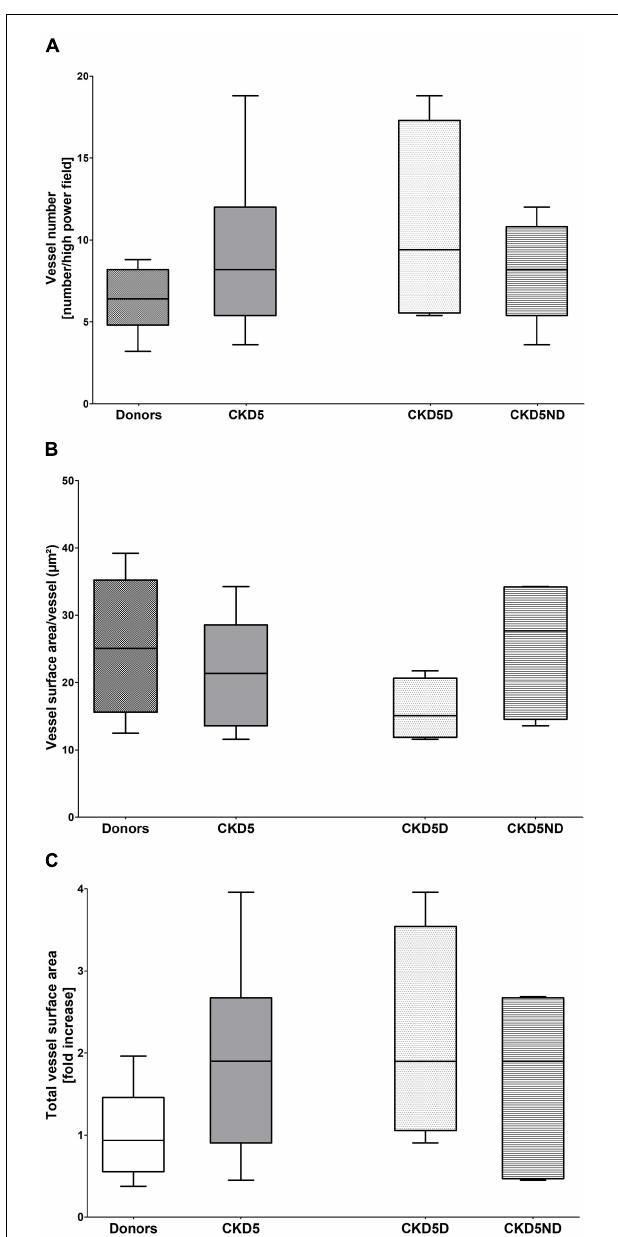
FIGURE 1 | Vessel quantification based on CD31 immunofluorescence in healthy donors vs. CKD patients including CKD5ND and CKD5D patients. (A) Number of CD31+ vessels per group. (B) CD31+ vessel surface area per vessel (total CD31+ vessel surface area / vessel number) in µ m 2 . (C) Total surface area of CD31 expression in fold increase. Differences are not statistically significant.